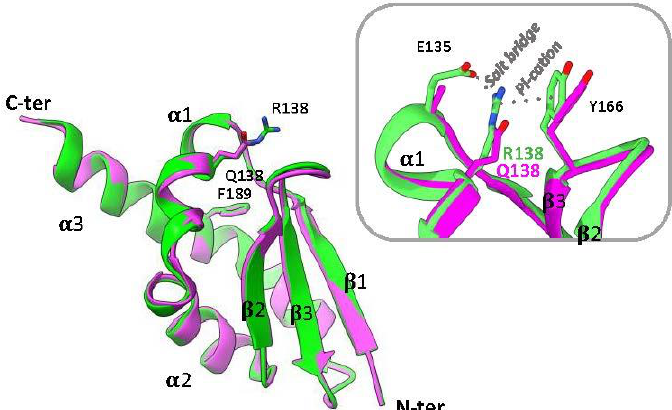
Figure 1. Superposition of the three-dimensional structure of the KH0 (green) and KH0-R138Q domain (magenta) of FMRP represented as a cartoon (from pdb codes 4QVZ and 4QW2, respectively). The residues Arg138/Gln138 and Phe189 are shown in stick representation. Secondary structure elements are labeled. The blow-up shows that Arg138 engages in a salt bridge with Glu135 and makes a Pi-cation interaction with Tyr166.